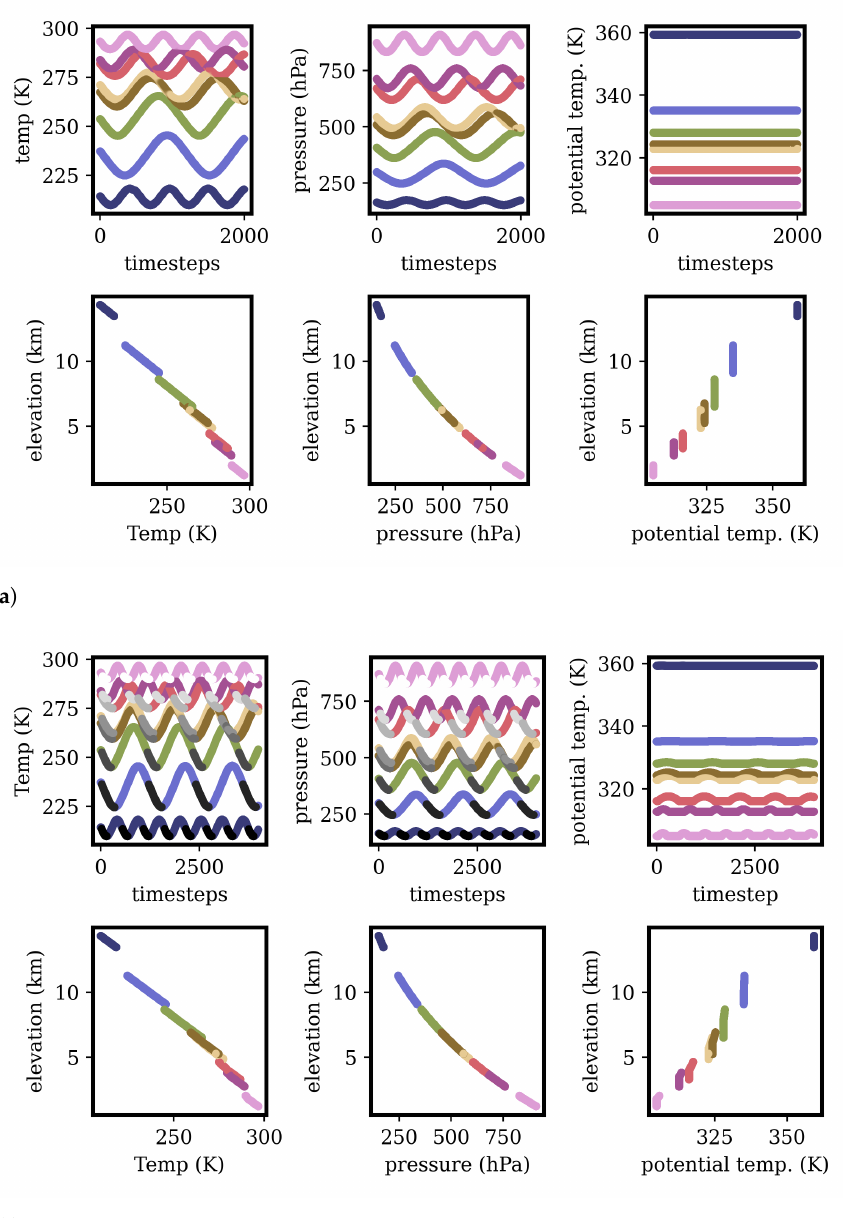
Figure 9. Particle attributes over time and varying elevation for: ( a ) eight dry air particles ( b ) eight saturated air particles; note that the grayscale indicates the particles are